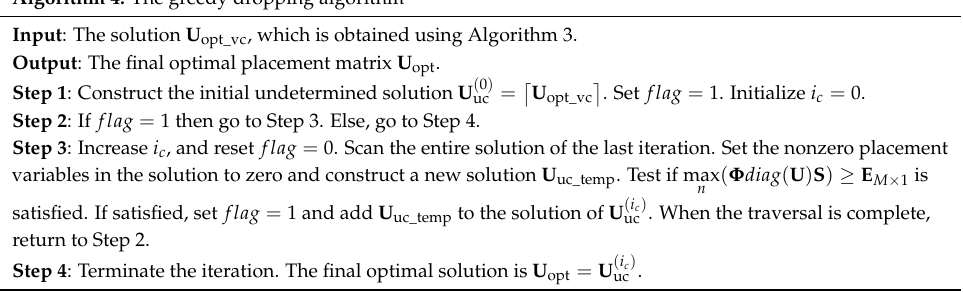
Algorithm 4: The greedy dropping